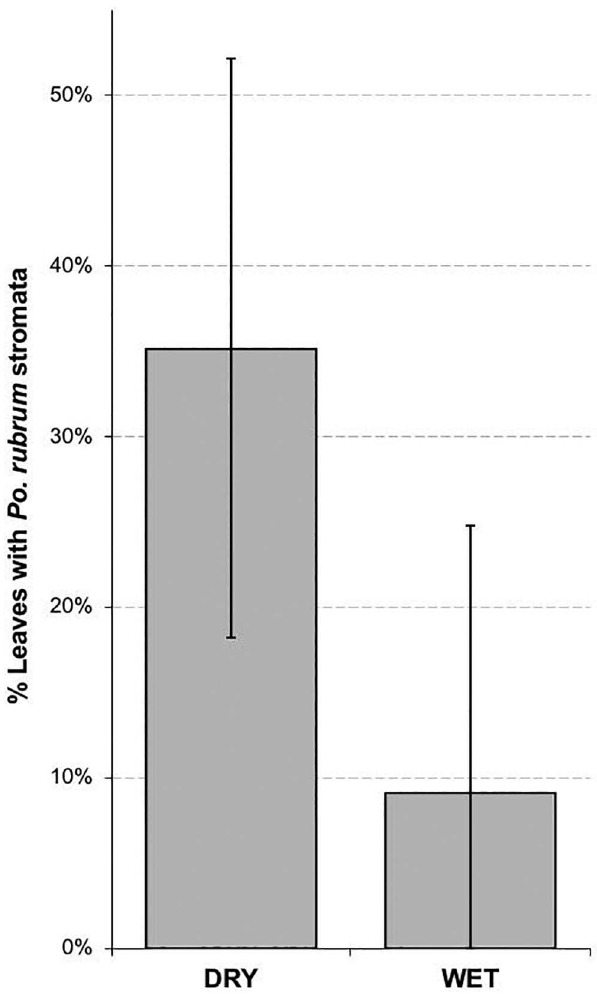
Figure 3 – Percentage of Prunus spinosa leaves infected with Polystigma rubrum was lower in trees growing winter-flooded soil (WET) than in dry soil (ANOVA P < 0.001; n = 12 per